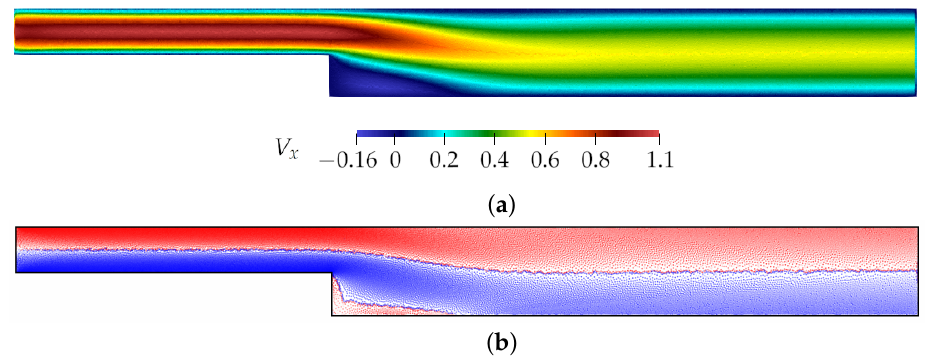
Figure 10. Horizontal component of the flow velocity ( a ) and vortex particles positions ( b ) in steady- state regime in the channel with backward-facing step; sources and sinks are placed along the left (“inlet”) and right (“outlet”) cross-sections,